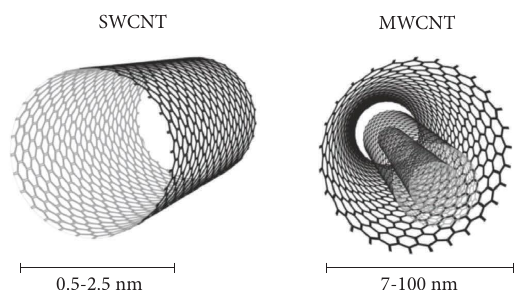
Figure 2: Te shape and size of a single-walled carbon nanotube and a multi-walled carbon nanotube (reprinted from Ribeiro et